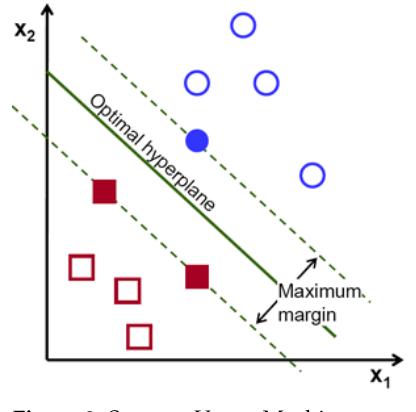
Figure 3. Support Vector